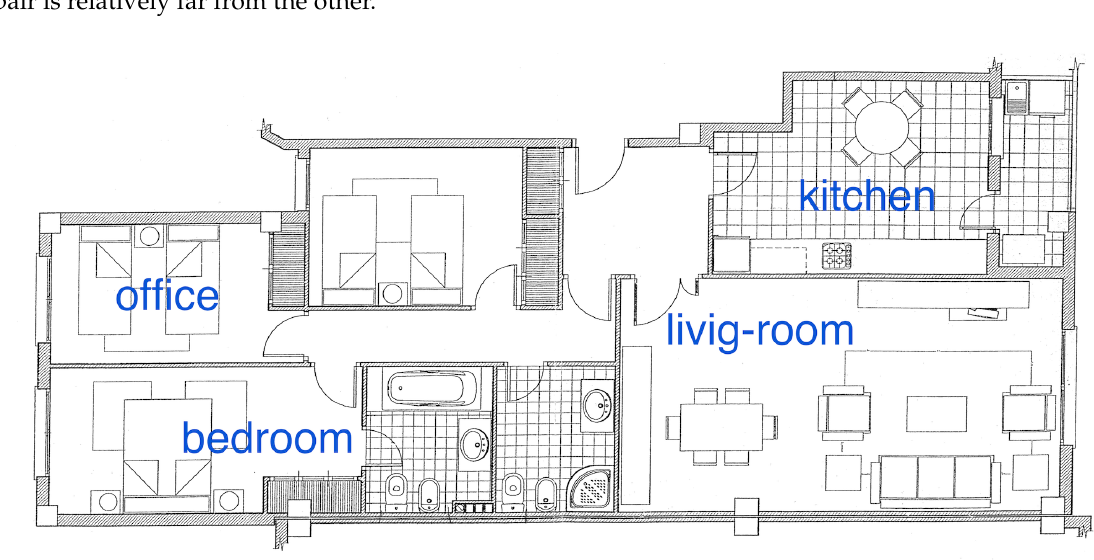
Figure 7. Scenario number 1 used in the